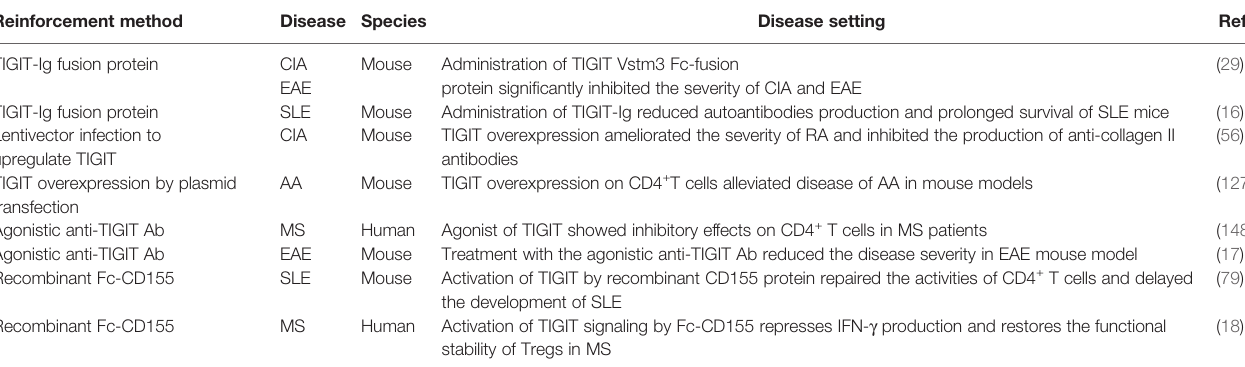
TABLE 2 | TIGIT reinforcement studies aimed at treat autoimmune diseases. Reinforcement method Disease Species Disease setting